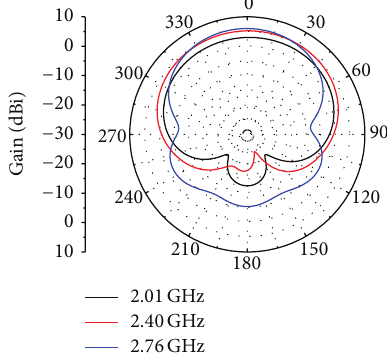
Figure 4: Radiation pattern in the H-plane (azimuth).